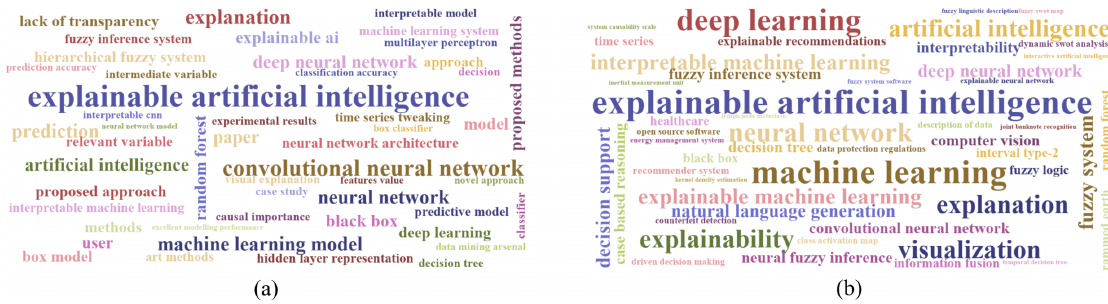
Figure 6. Word cloud of the ( a ) author-defined keywords and ( b ) keywords extracted from the abstracts through natural language processing. The font size is proportional to the number of occurrences of the terms and different colours are used to discriminate terms with equal font